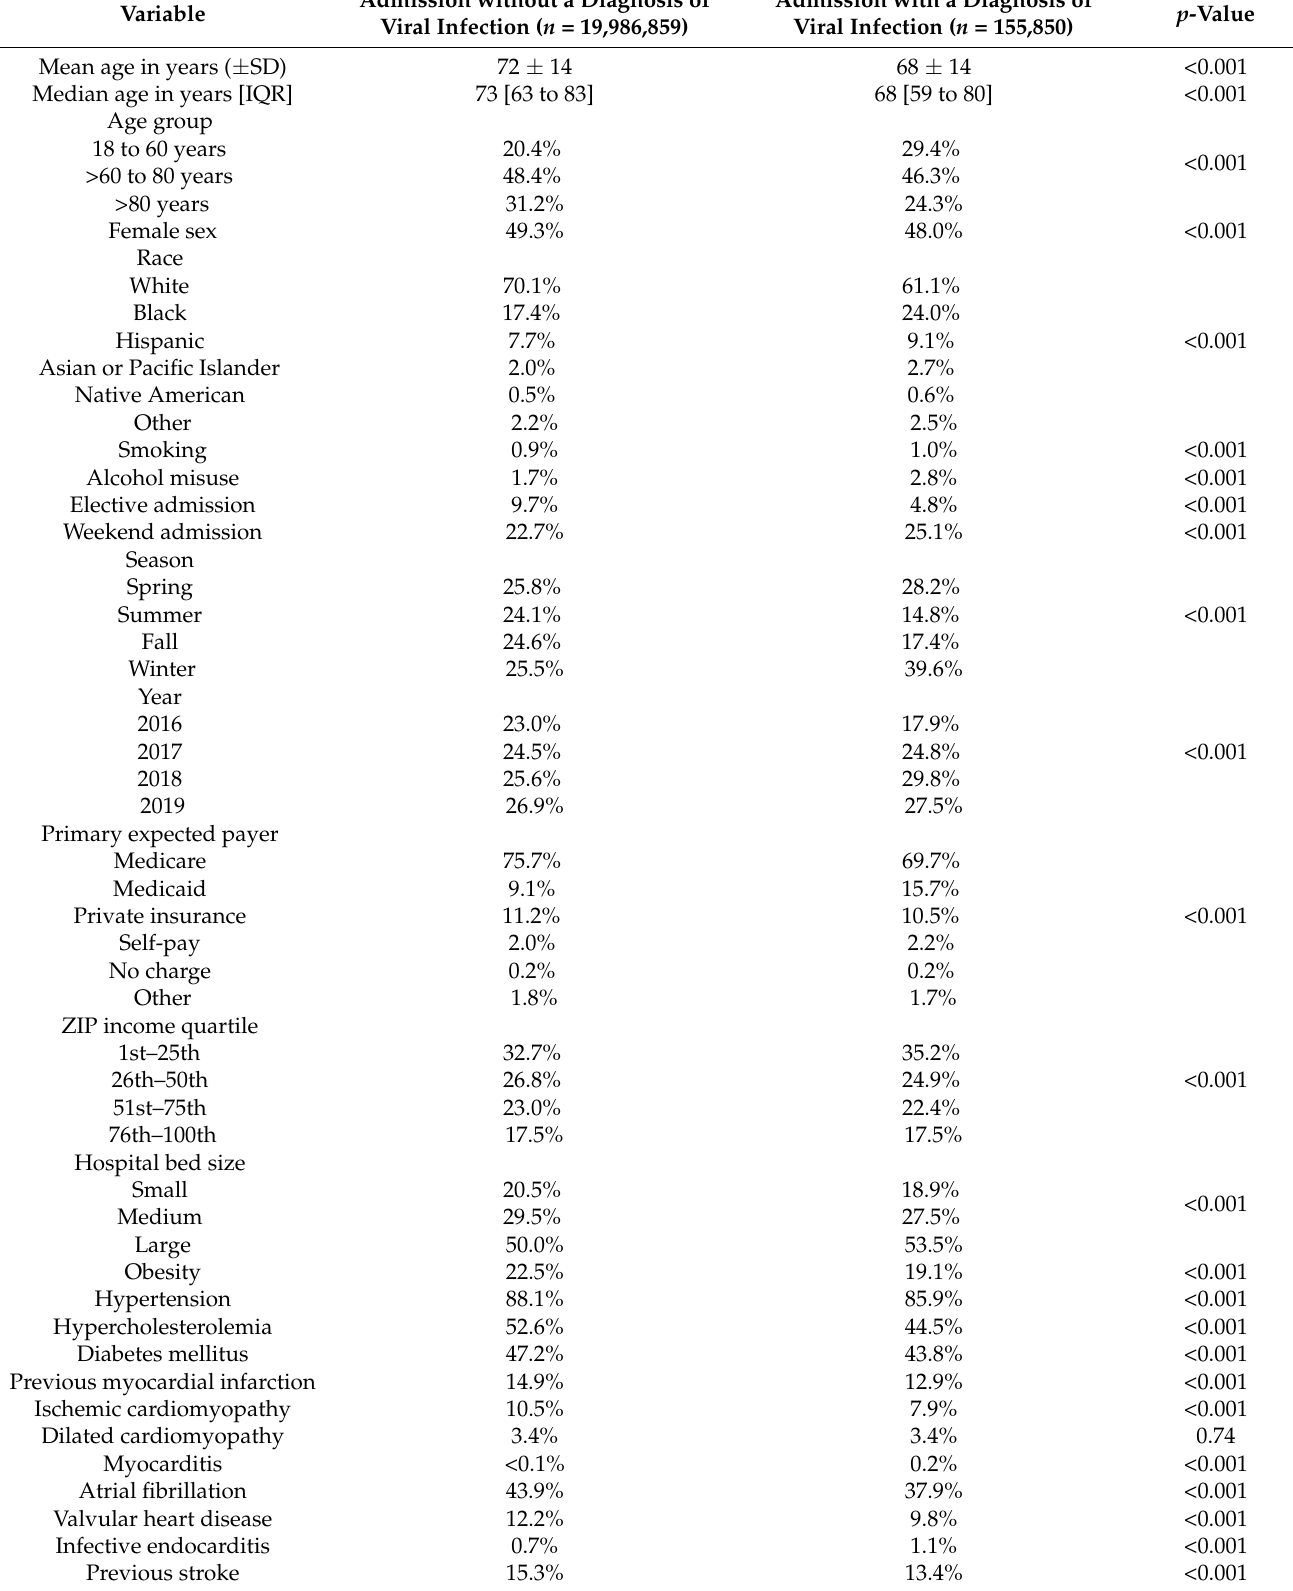
Table 1. Characteristics and comorbidities of records with and without viral infections with a hospital diagnosis of heart